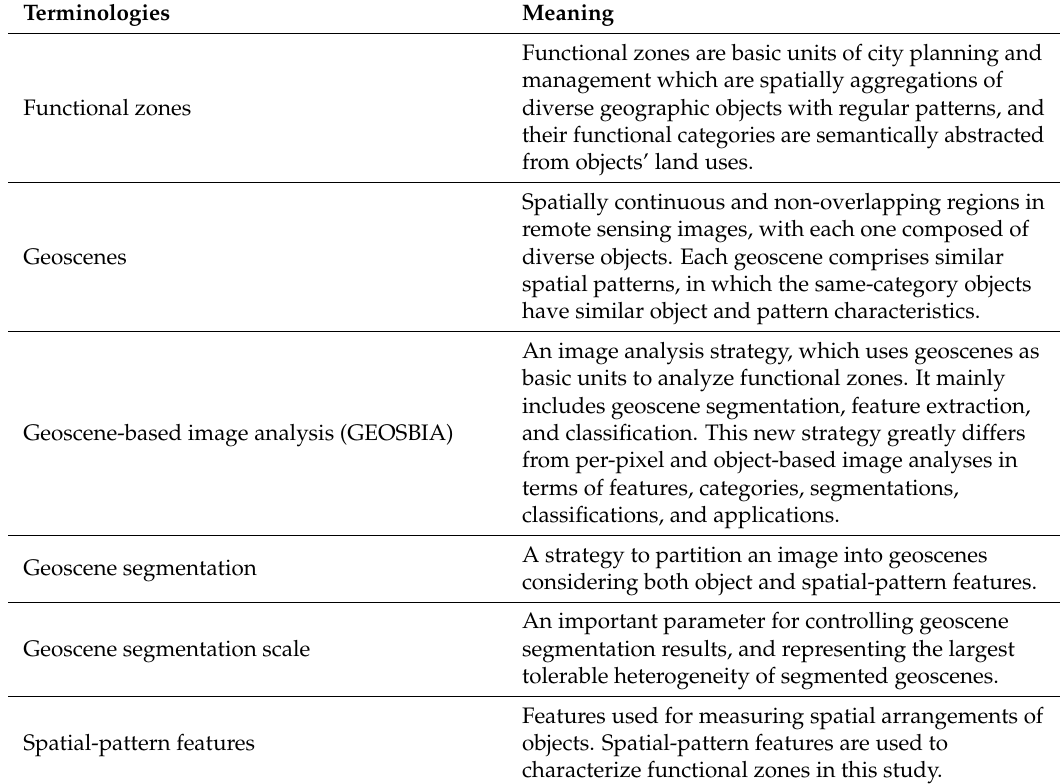
Table 2. Terminologies proposed in this